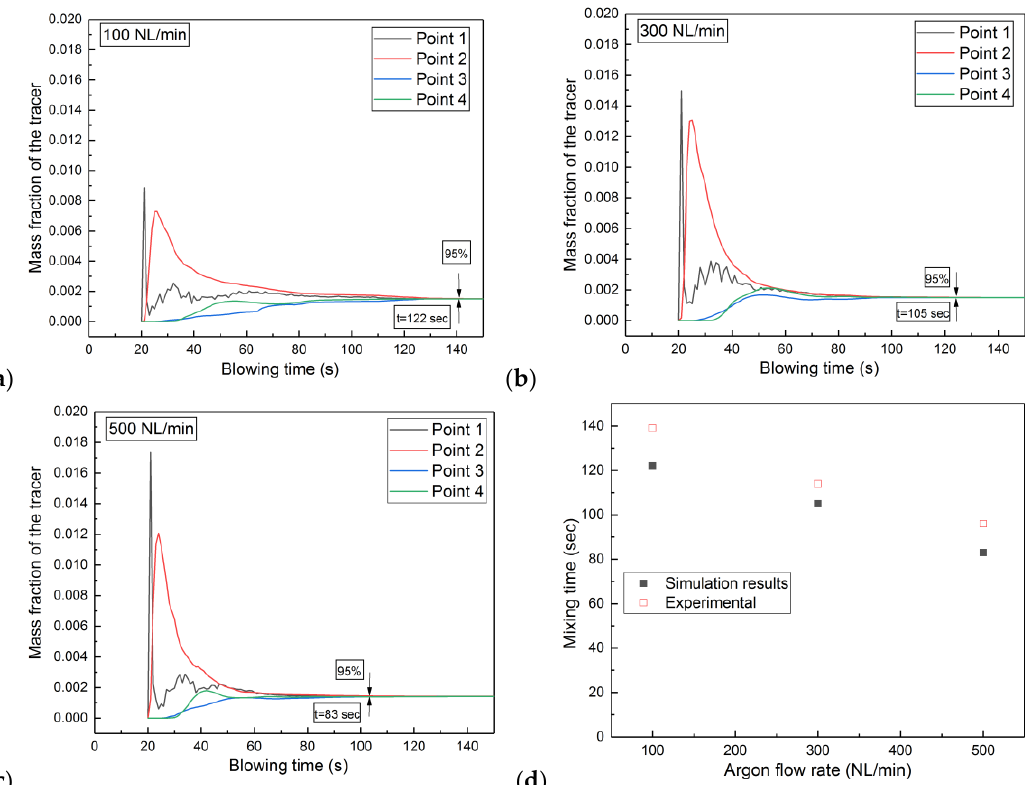
10 of 13 Figure 9. Tracer concentration profiles for different gas flow rates of 100 (left), 300 (middle), and 500 (right) NL/min with different time intervals: ( a ) 0 s ( b ) 5 s ( c ) 10 s ( d ) 20 s ( e ) 40 s ( f ) 60 s. Figure 9 displays the concentration profiles of the tracer inside the ladle after an addition time of 0 s, 5 s, 10 s, 20 s, 40 s, or 60 s for different argon flow rates. At 0 s, the tracer is injected through the generated open-eye which is located at the top-right side of the ladle furnace (see Figure 9a). As seen in Figure 9b, the tracer started to dissolve into the molten steel at 5 s, but moved to the ladle surface due to the direction of the high gas flow coming through the nozzle located at the bottom of the ladle. The dissolution of tracer was higher at a gas flow rate of 500 NL/min, when compared to a low gas flow rate of 200 NL/min. The same trend of tracer distribution in the molten steel was followed at 10